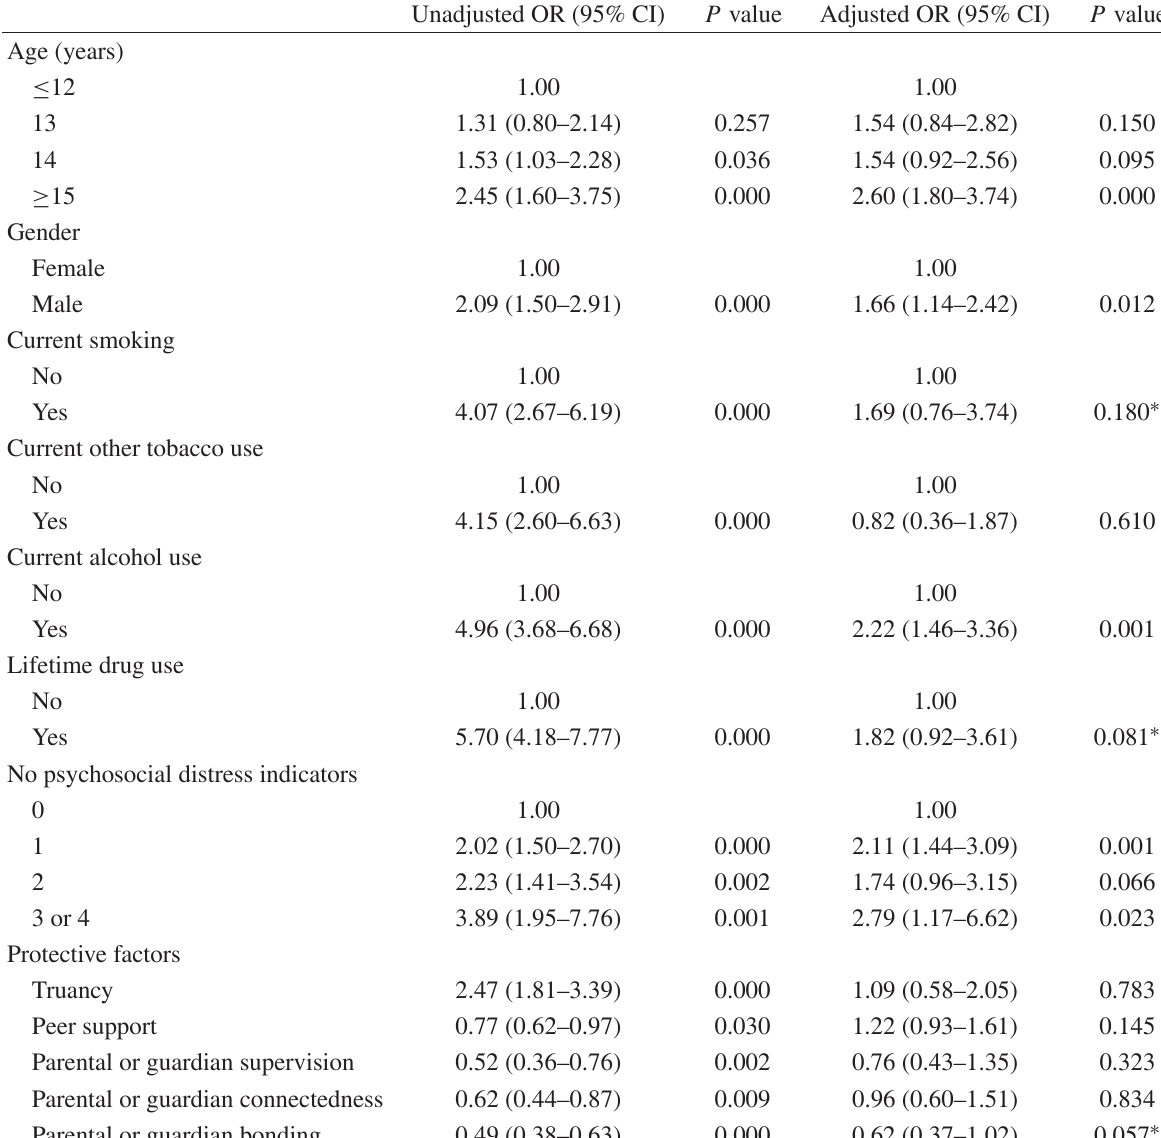
TABLE 2: Bivariate and multivariable logistic regression analysis of factors that are associated with sexual intercourse in the past 12 months among adolescents in Thailand,